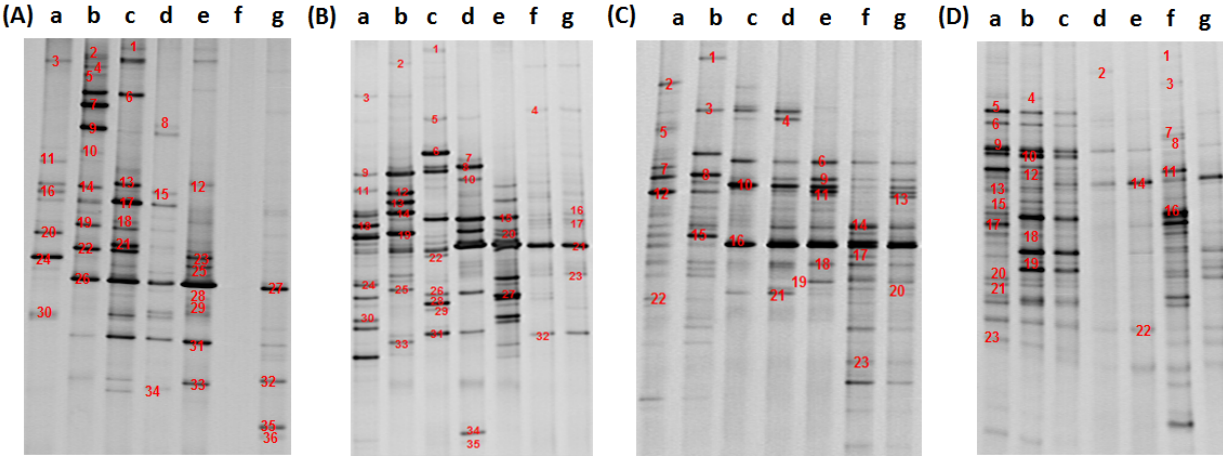
Figure 2. DGGE patterns of 16S rDNA fragments amplified from water sample DNA with primer V3. ( A ) Feburary, ( B ) May, ( C ) August, ( D ) November. a : source water; b : pre- ozone-treated effluent; c : flocculation and sedimentation tank effluent; d : sand-filter-pool effluent; e : main ozone treatment tank effluent; f : active-charcoal-pool